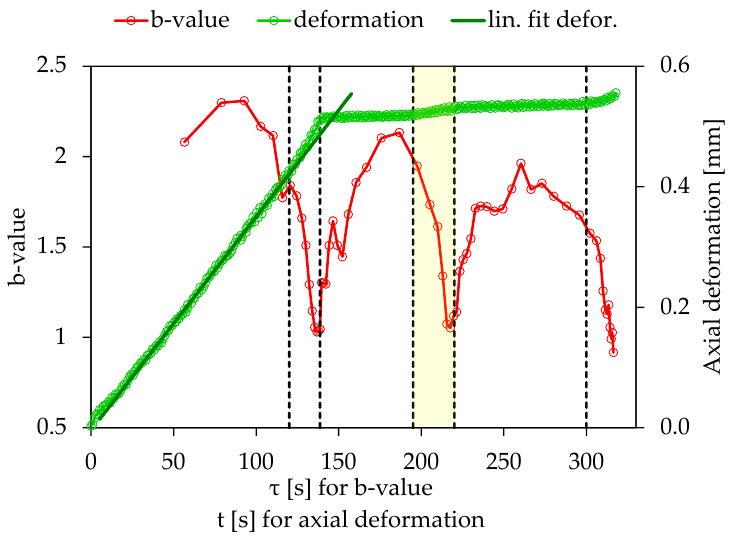
Figure 5. Temporal evolution of the b- value in juxtaposition with the axial mechanical deformation.